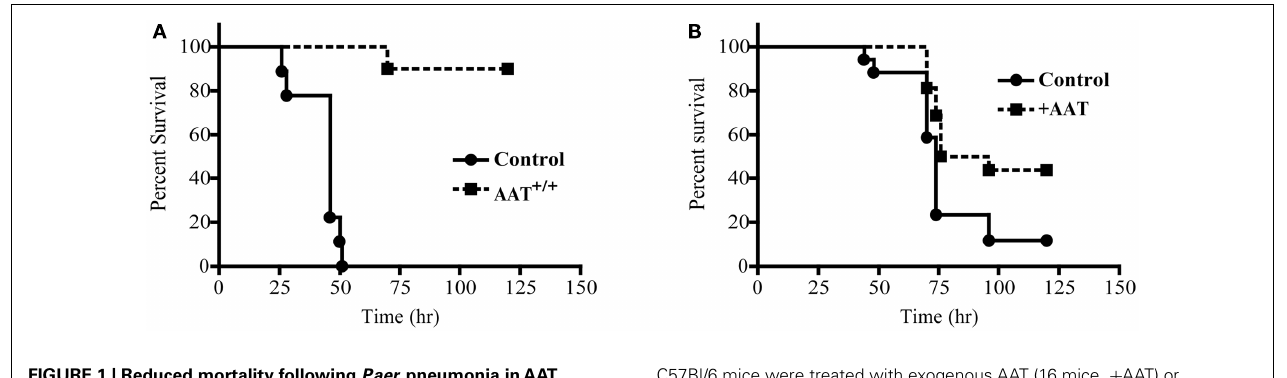
FIGURE 1 | Reduced mortality following P.aer pneumonia inAAT transgenic mice and in mice given exogenousAAT . In (A) 10 transgenic mice that express human AAT in lung tissue (AAT + / + ) and 9 C57Bl/6 (Control) mice were infected with inhaled P.aer . Kaplan–Meier survival curves are shown for 120h following infection. Reduced mortality in AAT + / + mice was statistically significant ( p < 0.0001). In (B)